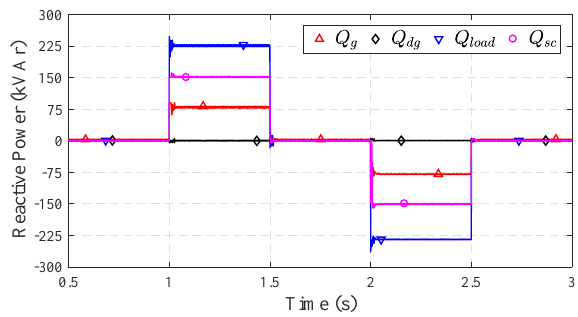
Figure 16. Three-phase reactive powers of the grid, DG, load and smart